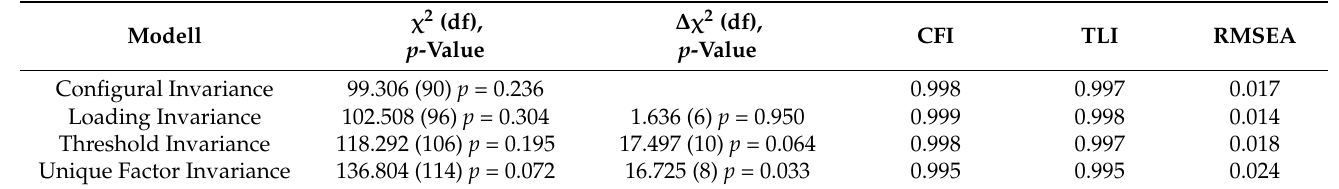
Table 1. Fit statistics of the models for testing longitudinal measurement invariance of the factors G-Score and